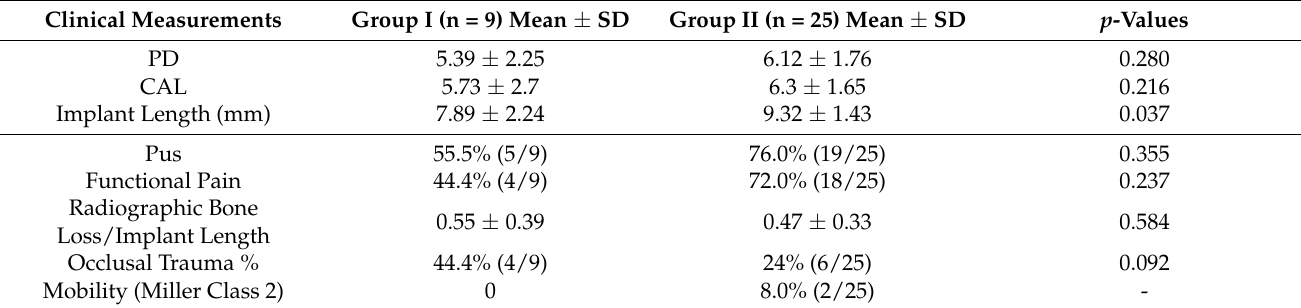
Table 2. Comparison of periodontal measurements and Dental Implant Health Scale parameters. Clinical Measurements